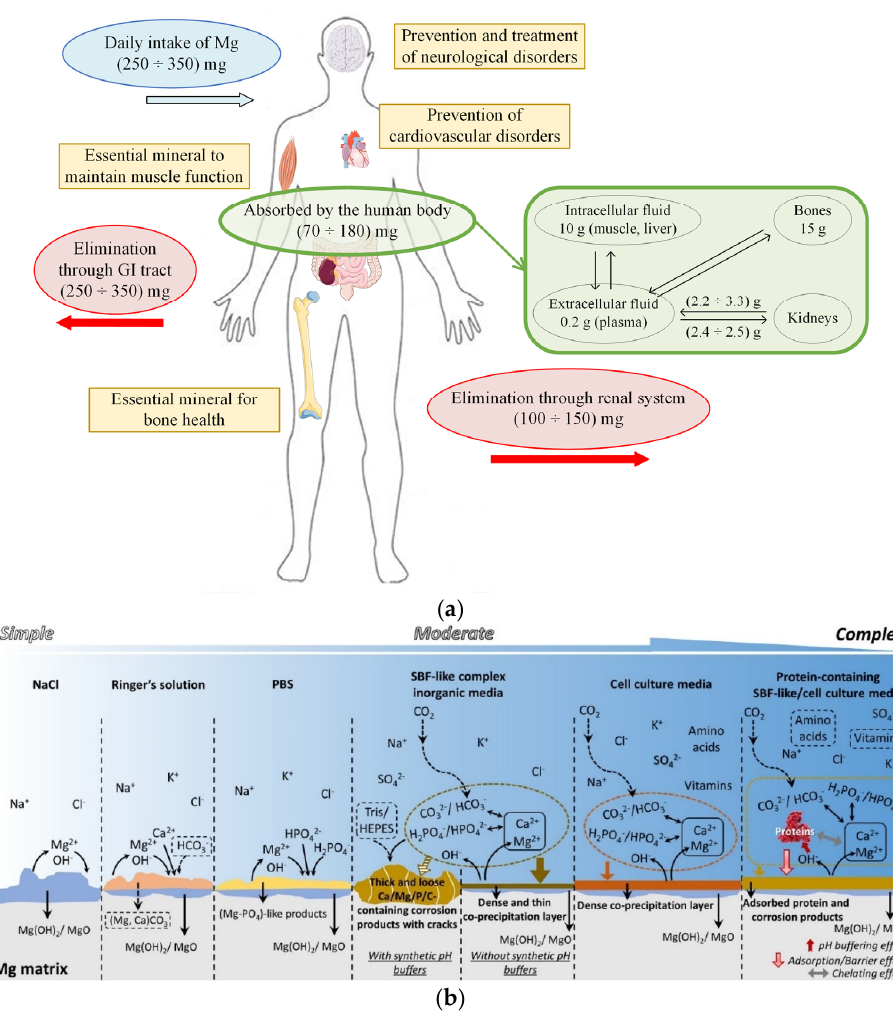
Figure 2. ( a ) Magnesium cycle in the human body and its beneficial effects on different